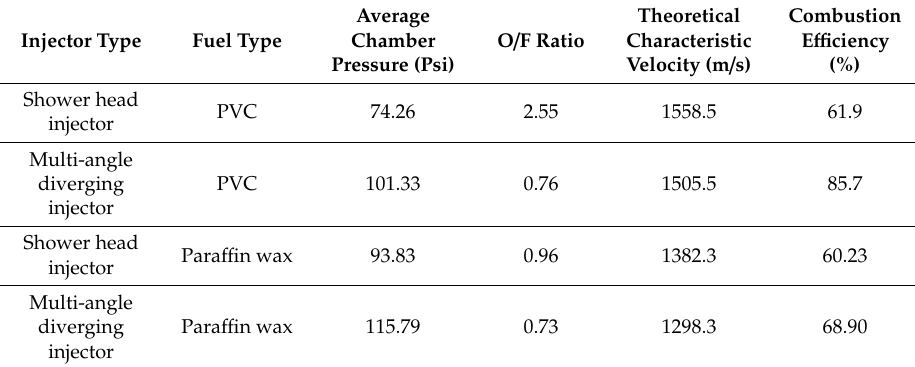
Table 2. Combustion e ffi ciency data for two injector